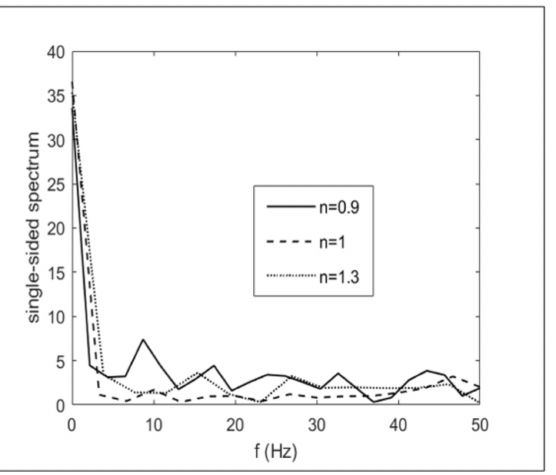
Figure 19. Frequency domains of fingertip transverse fluctuations for different